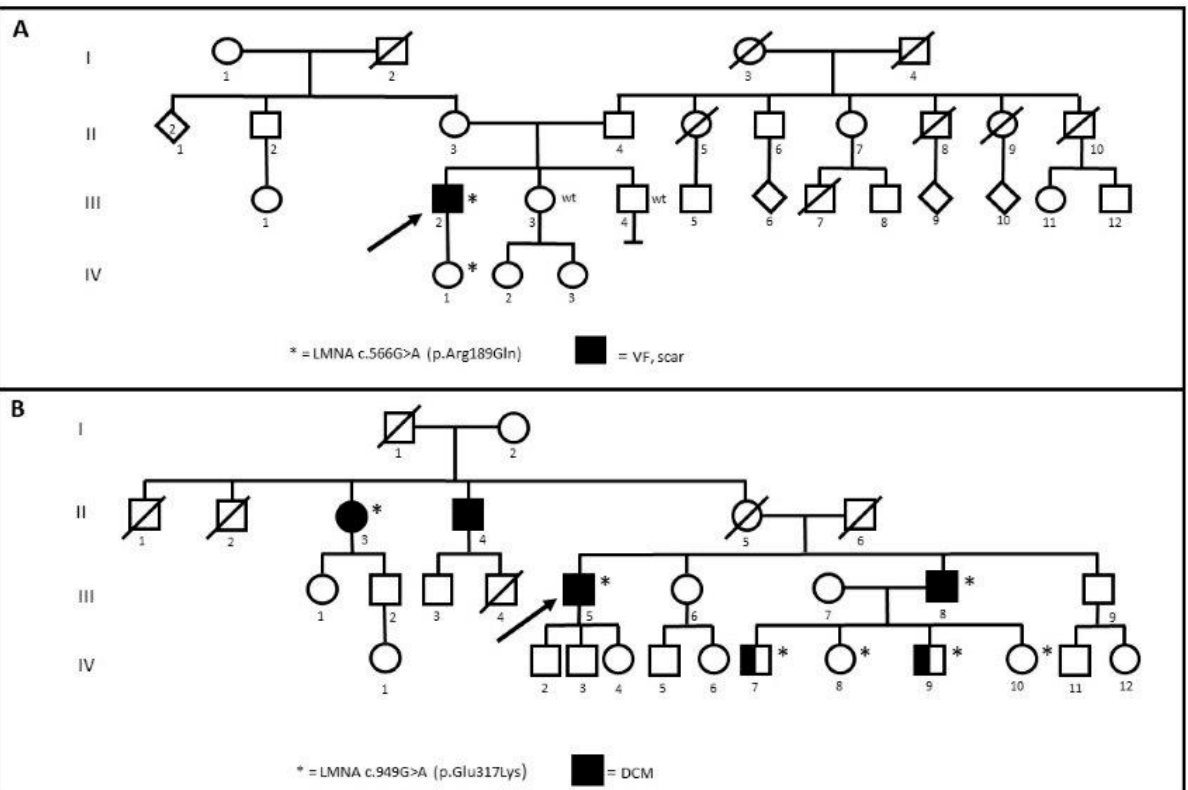
Figure 2. ( A ) Segregation of R189Q in Family 6. ( B ) Segregation of E317K in Family 14. Arrows indicate the proband. Wt: wild type. * stands for positive patients to Lamin A/C gene ( LMNA ) variants.